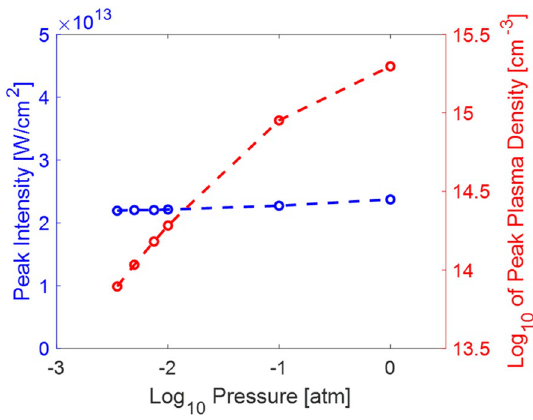
Figure 2. Simulation results showing the peak on axis intensity (blue) and the peak plasma density (red) scaled with